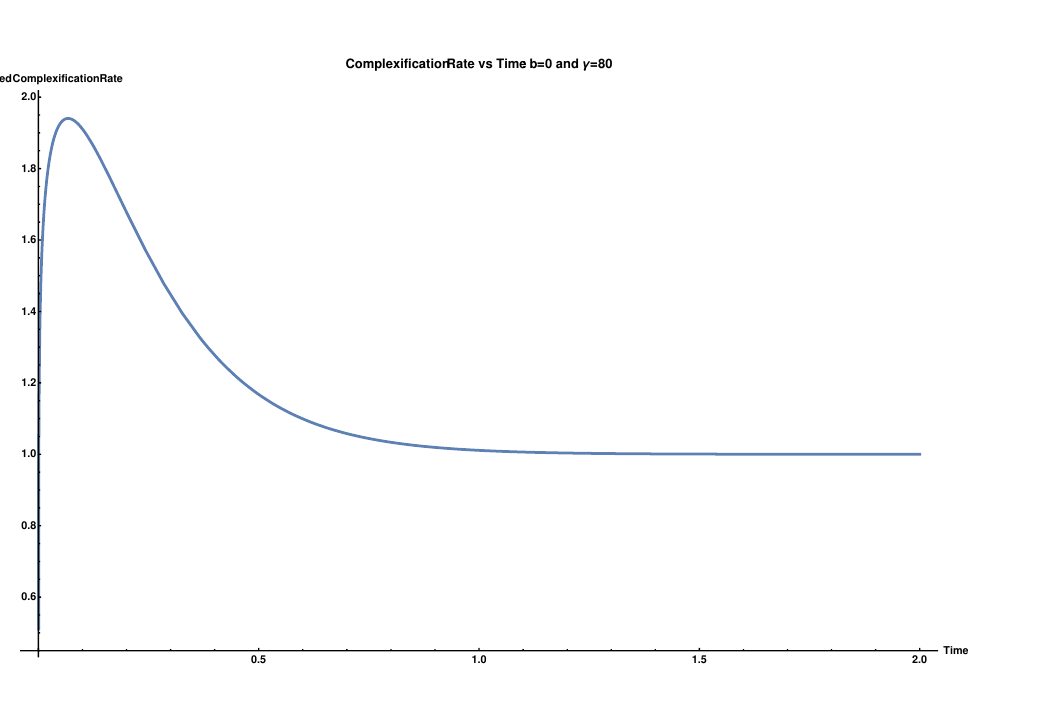
Figure 4 . Normalized complexi(cid:12)cation rate versus time in thermal units for (cid:13) = 80 and b = 0.